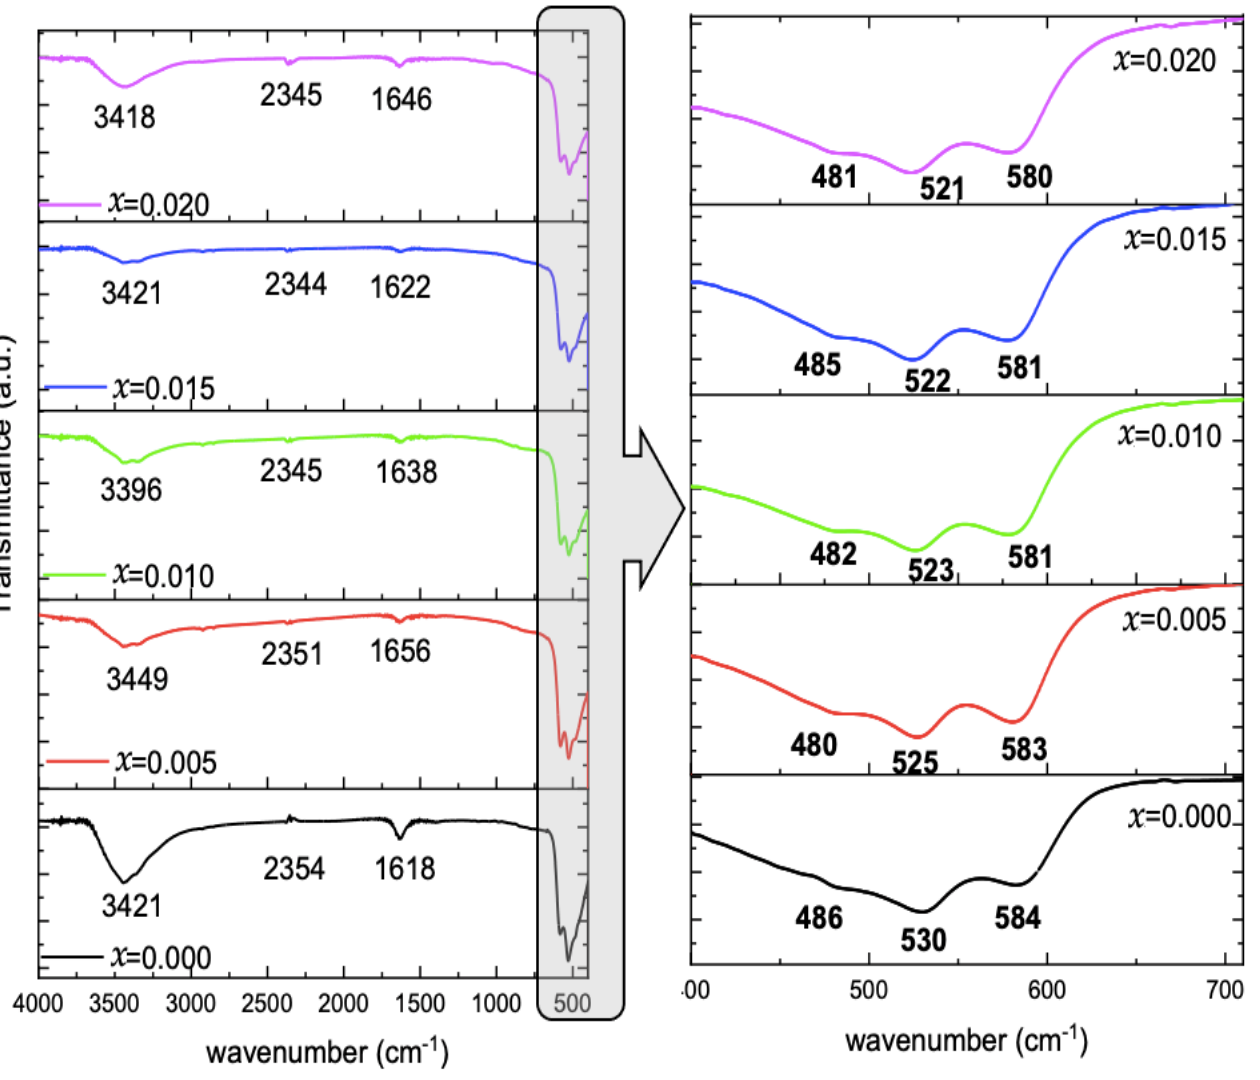
Figure 4. FTIR spectra of Cu 1 −x Mg x O NPs, and enlarged view for Cu-O vibrations.